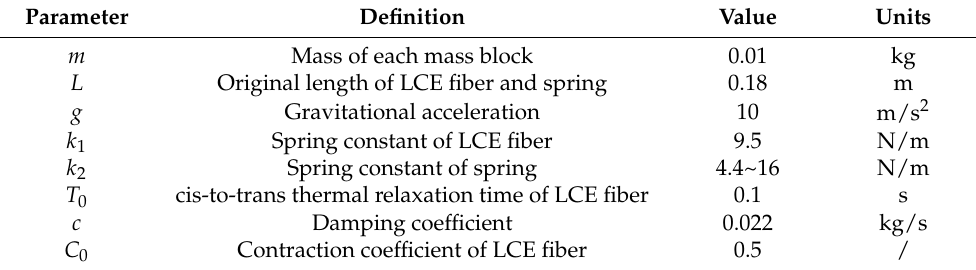
Table 1. Material properties and geometric parameters.